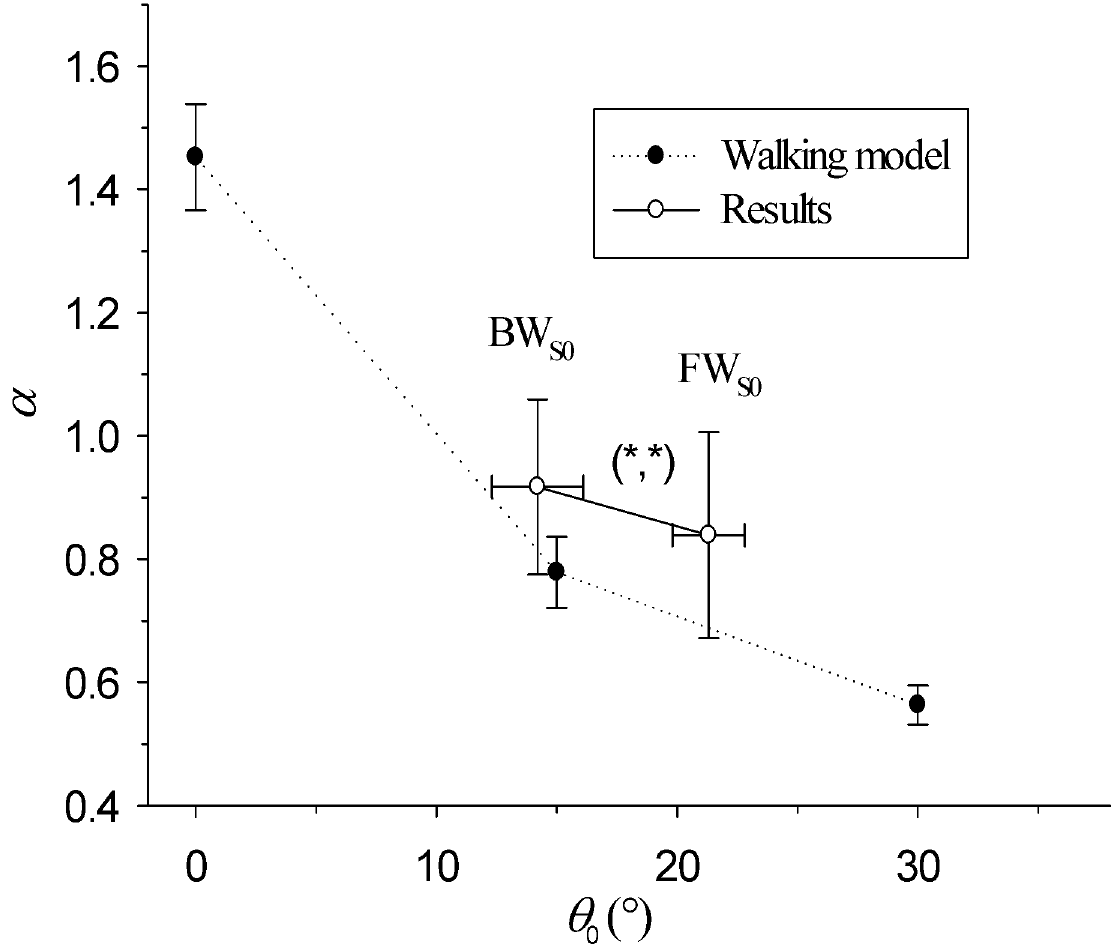
Fig 6. Evolution of the Hurst exponent ( α ) versus stride amplitude ( θ 0 ) in the FW S 0 and BW S 0 conditions (empty open circles). Data from [6] (closedcircles) are linked with dotted lines for clarity sake. Error bars represent SD. The notation( NS / * , NS / * ) denotesstatistically significantdifferences ( * ) or no ( NS ) in the ( α , θ 0